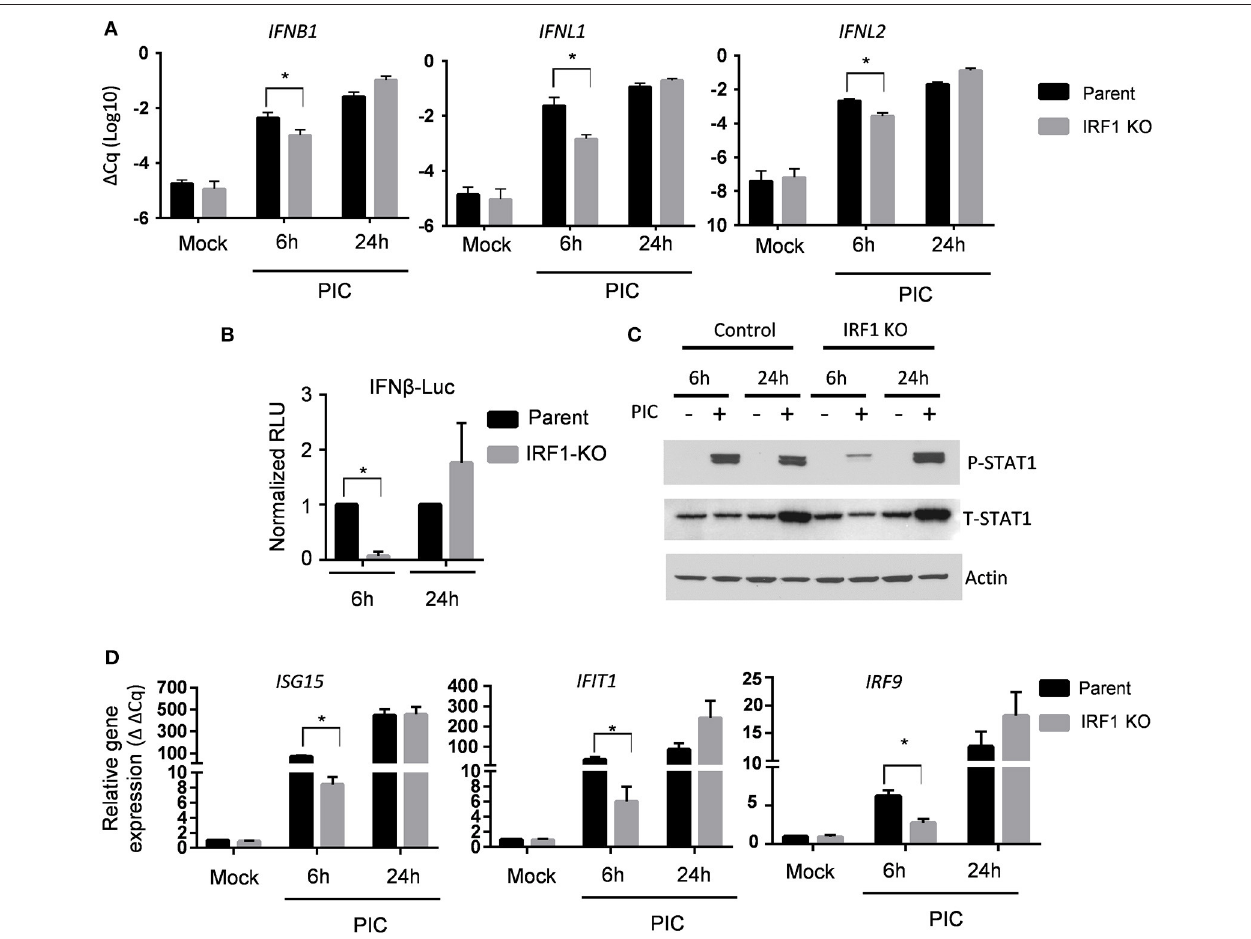
FIGURE 2 | IRF1 is required for early expression of types I and III IFNs and ISG expression. (A) Parent BEAS-2B and IRF1 KO cells were transfected with poly I:C, and expression of IFN β , IFN λ 1, or IFN λ 2 transcripts were examined by RT-qPCR at 6h or 24h after poly I:C transfection. Data represent mean ± SEM from four independent experiments. (B) Parent BEAS-2B and IRF1 cells were transfected with a plasmid expressing firefly luciferase under the control of the IFN β promoter or a plasmid constitutively expressing Renilla luciferase. Cells were then transfected with poly I:C and luciferase expression was examined at 6h or 24h afterwards. Firefly luciferase expression was normalized to Renilla luciferase expression and expressed as relative light units (RLU). Data shown are mean ± SD from three independent experiments. (C) IRF1 KO and parent cells were transfected with poly I:C, and cell lysates were immunoblotted for STAT1 phosphorylation (Y701). (D) Experimental protocol is same as A except that ISG expression was measured by RT-qPCR. Relative gene expression (2 − 11 Cq ) is shown. Data represent mean ± SD from three independent experiments. *Statistically